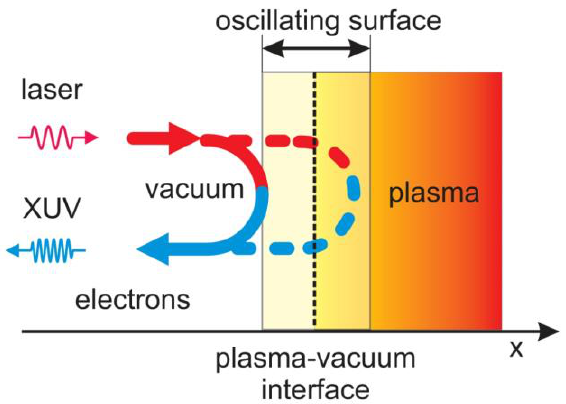
Figure 3. Schematic showing the basic idea of the relativistic oscillating mirror mechanism.